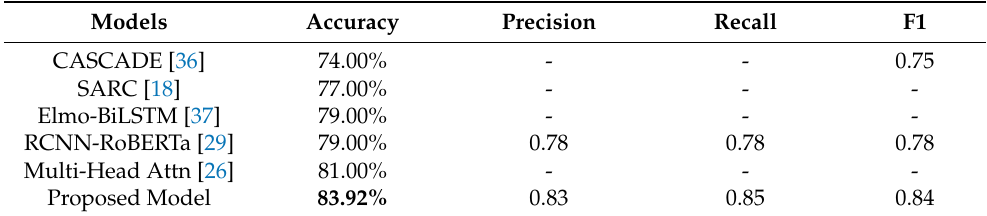
Table 2. Performance comparison of SARC dataset.